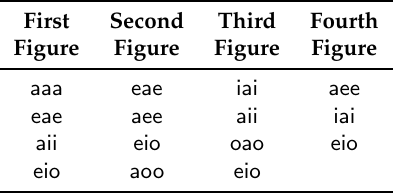
Table 1. Valid syllogistic moods.